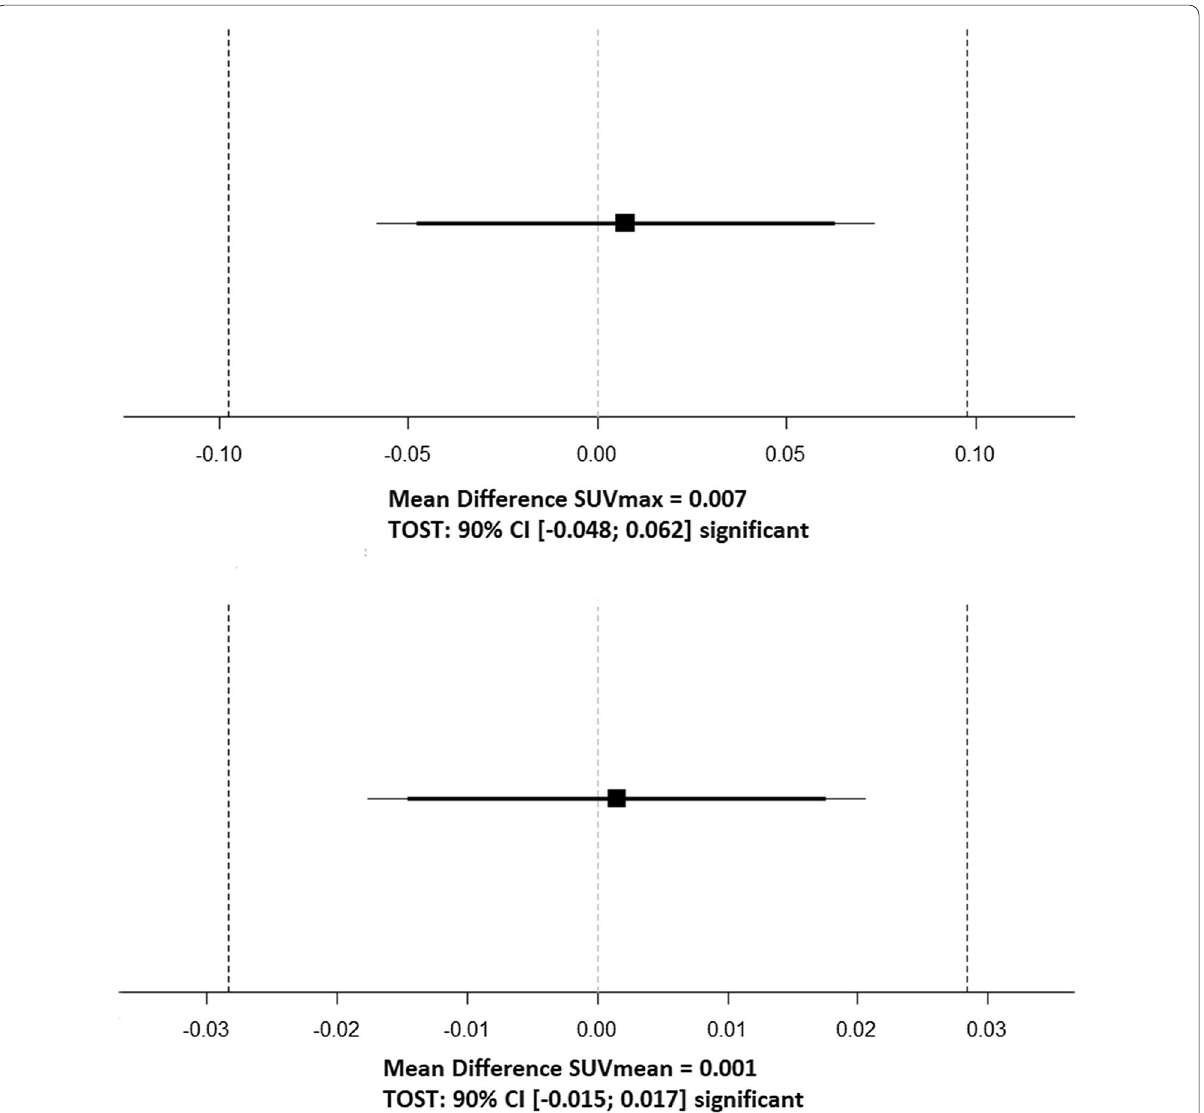
Fig. 4 Comparison of SUV max 75 s and 57 s PET/CT datasets and SUV mean 75 s and 57 s PET/CT images of 214 [ 18 F]‑FDG‑avid lesions by performing the TOST equivalence test